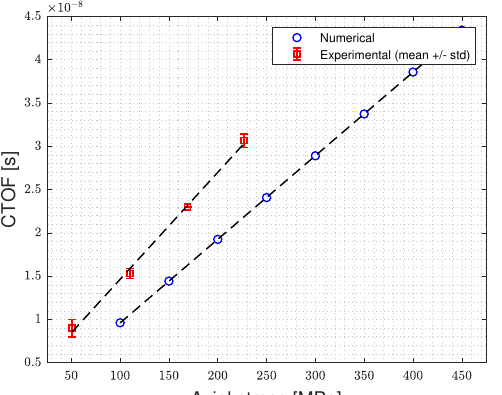
Figure 17. Numerical and experimental linear relationship between the CTOF of the ultrasonic wave and the bolt axial stress